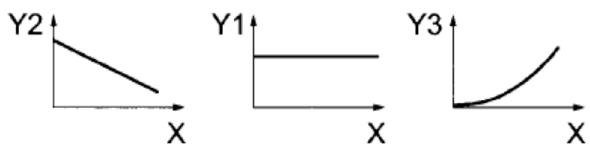
Figure 4. The TSRST test principle with restrained thermal stress, where: X—time, Y1—strain, Y2—temperature, and Y3—stress [41].